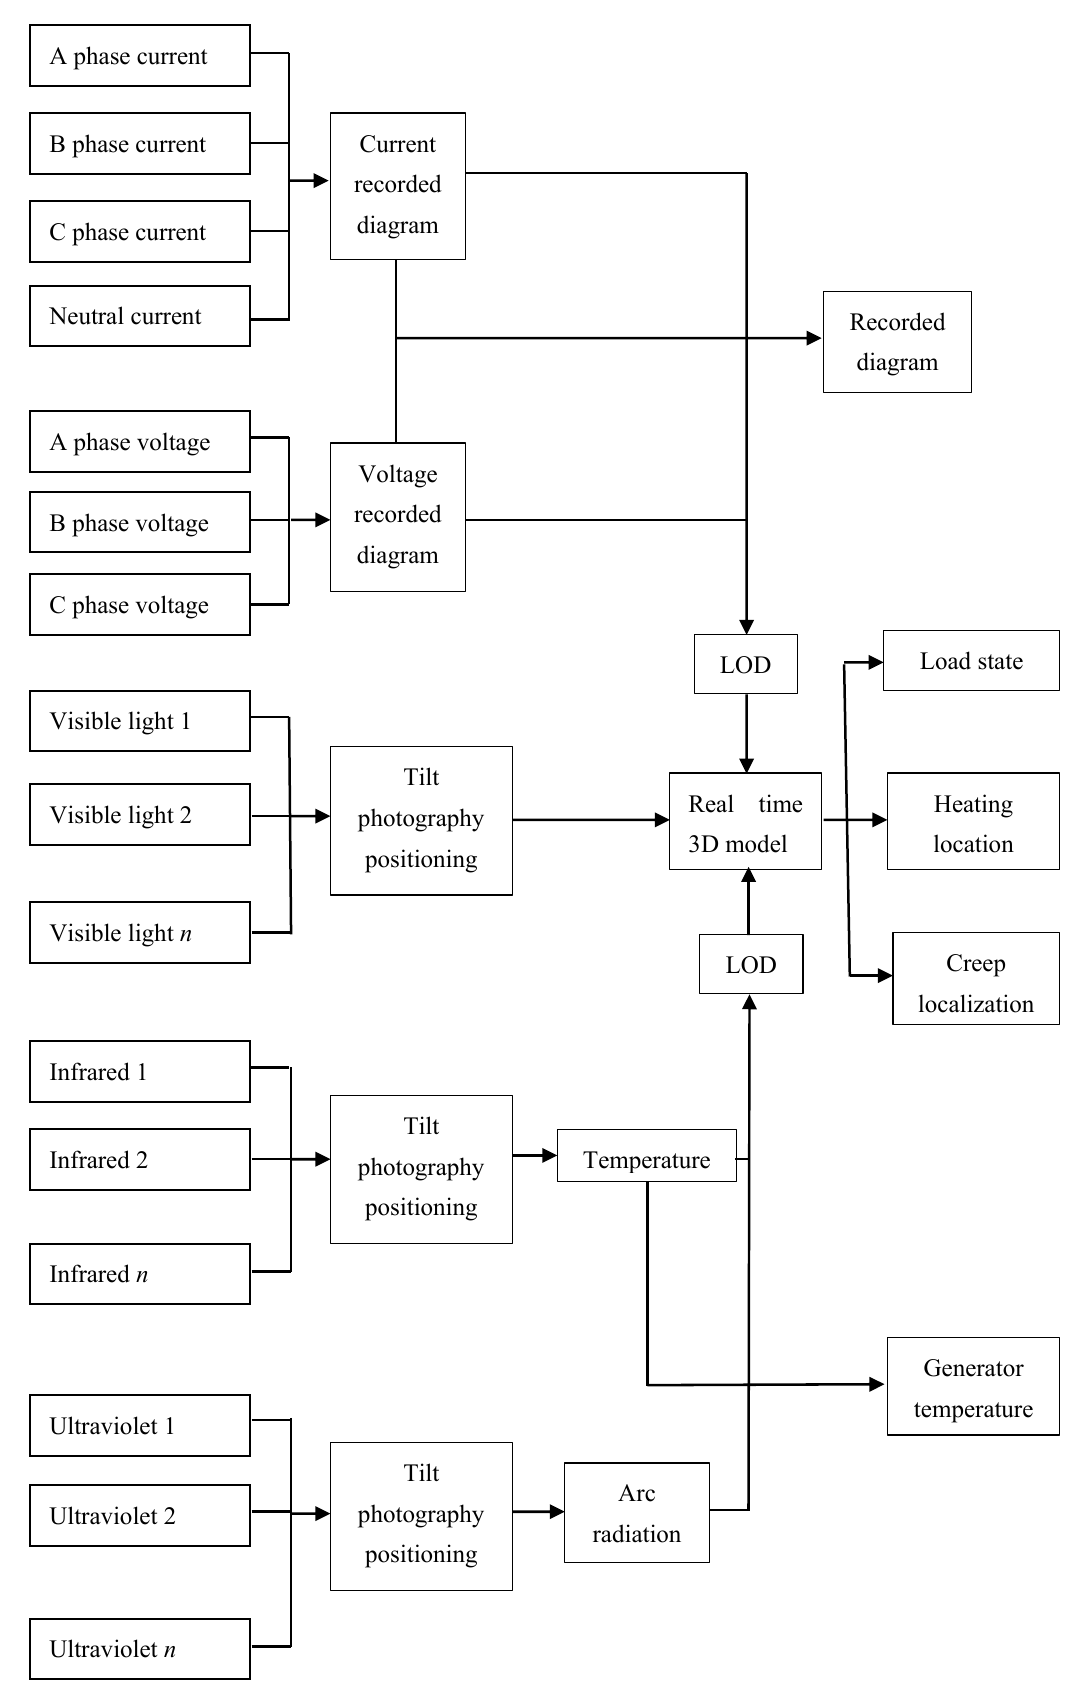
Figure 3. Data collection for large generator.